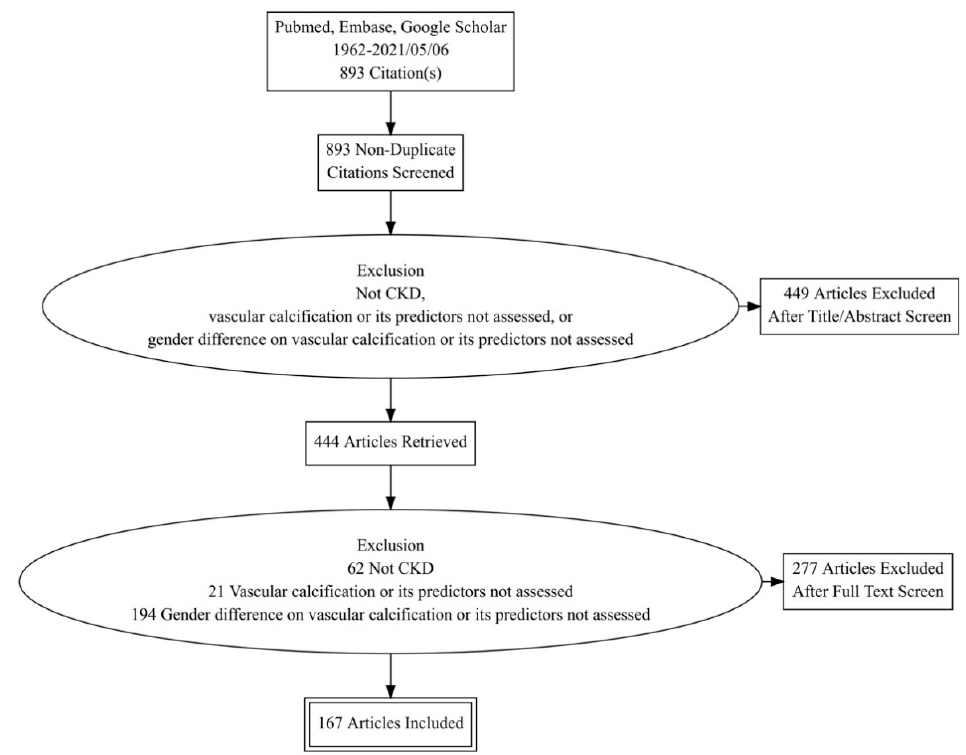
Figure 1. Literature selection algorithm of this review. CKD, chronic kidney disease.